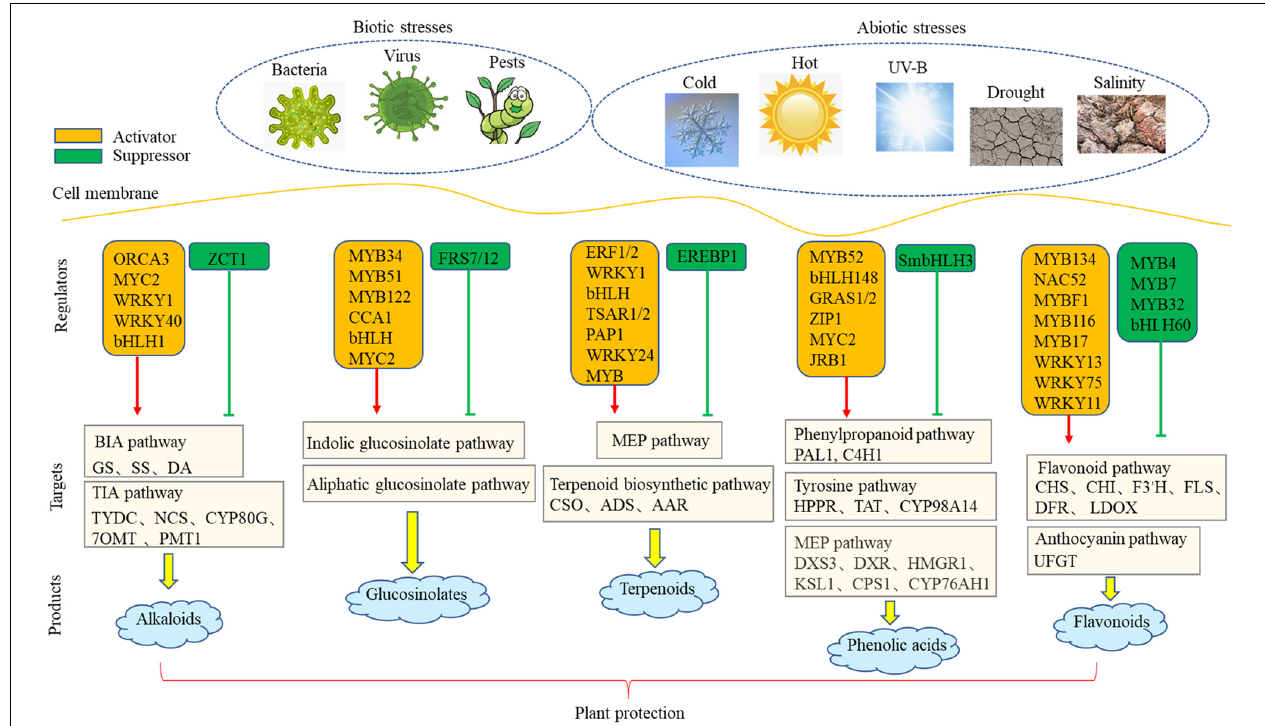
FIGURE 1 | The network of transcriptional regulation of plant under biotic and abiotic stresses. Red arrow indicated activation pathways and green arrow indicated inhibition pathways.